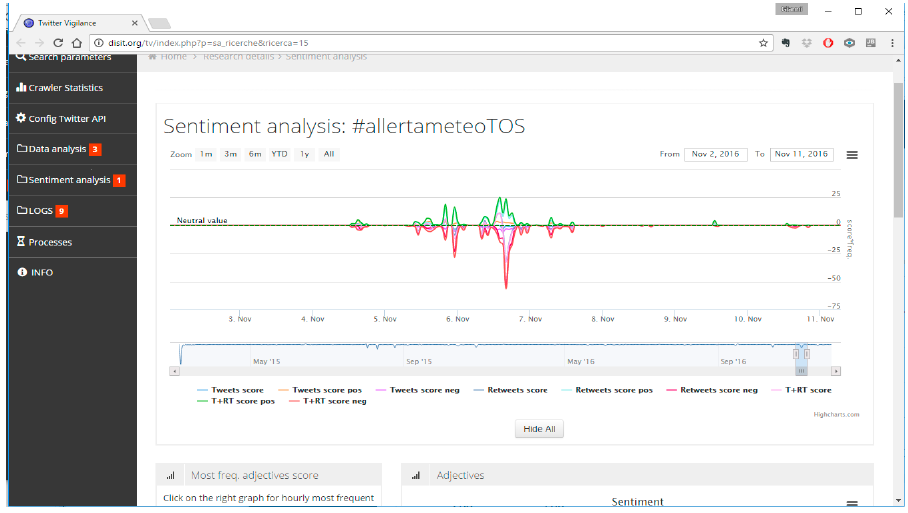
Figure 11. Sentiment analysis signal processing.